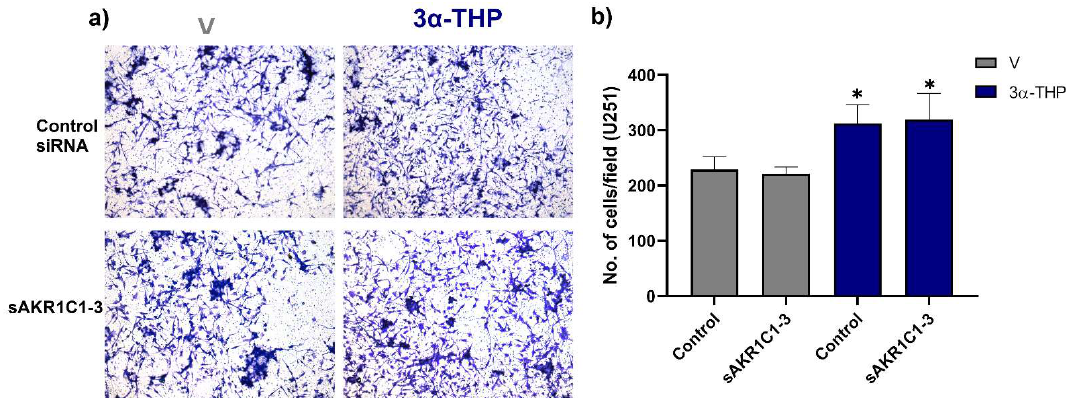
Figure 5. Effect of 3α-THP and the silencing of AKR1Cs on the invasion of U251 cells. ( a ) Representative images of U251 cells transfected with the negative control siRNA (Control siRNA), the siRNA against AKR1C1-3 (sAKR1C1-3) and treated with V or 3α-THP. ( b ) Graph of the number of invading U251 cells per field. Each point represents the mean ± SEM. * p < 0.05 THP (control SiRNA and sAKR1C1-3) vs. V (control siRNA and sAKR1C1-3) n = 4.